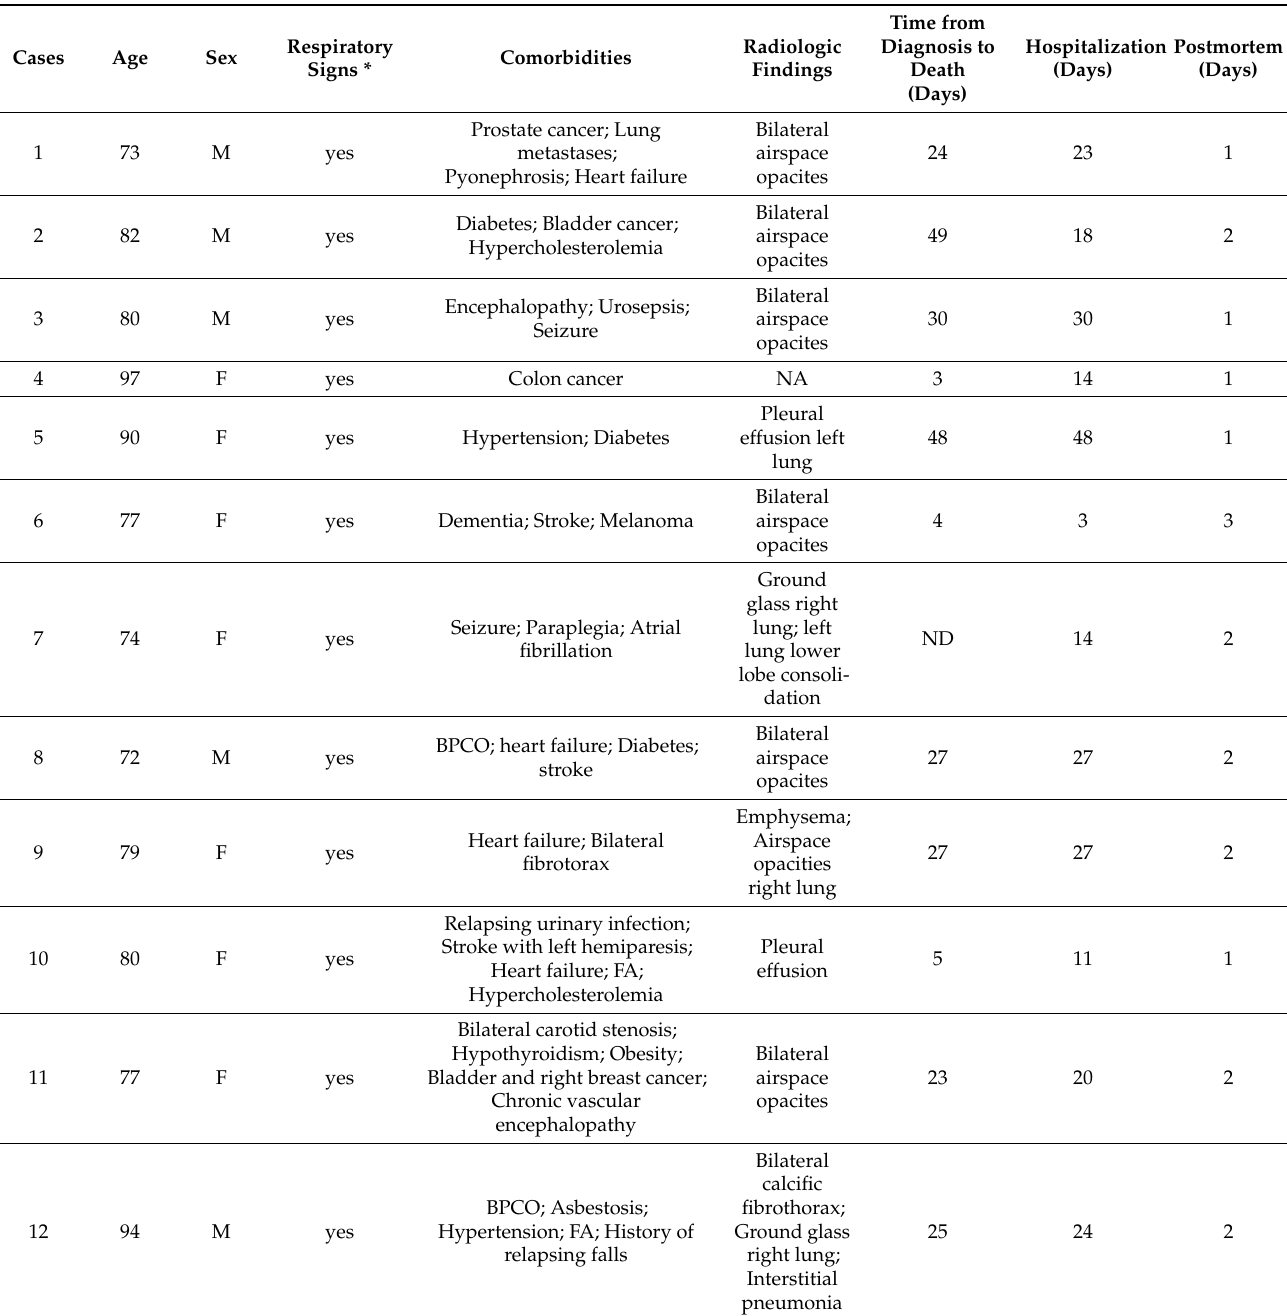
Table 1. Clinical